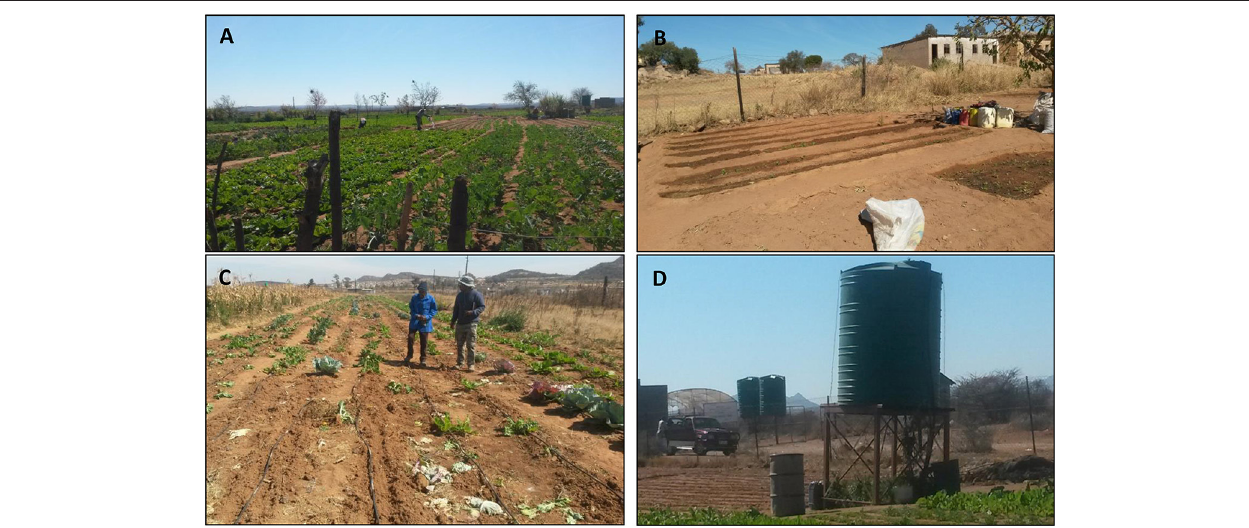
FIGURE 8 | Examples of agricultural activities in Limpopo Province, South Africa. (A) Agricultural fields at Mamotintane, where the total farm size is 9 ha with scattered rectangular farm plots for individual smallholder farmers. (B) A community-shared field (1 ha) at Segoptje. (C) A field 4 ha in size at Sickline with rectangular farm plots. (D) Irrigation system used for watering crops during the dry season (photos: Rirhandu Chauke).